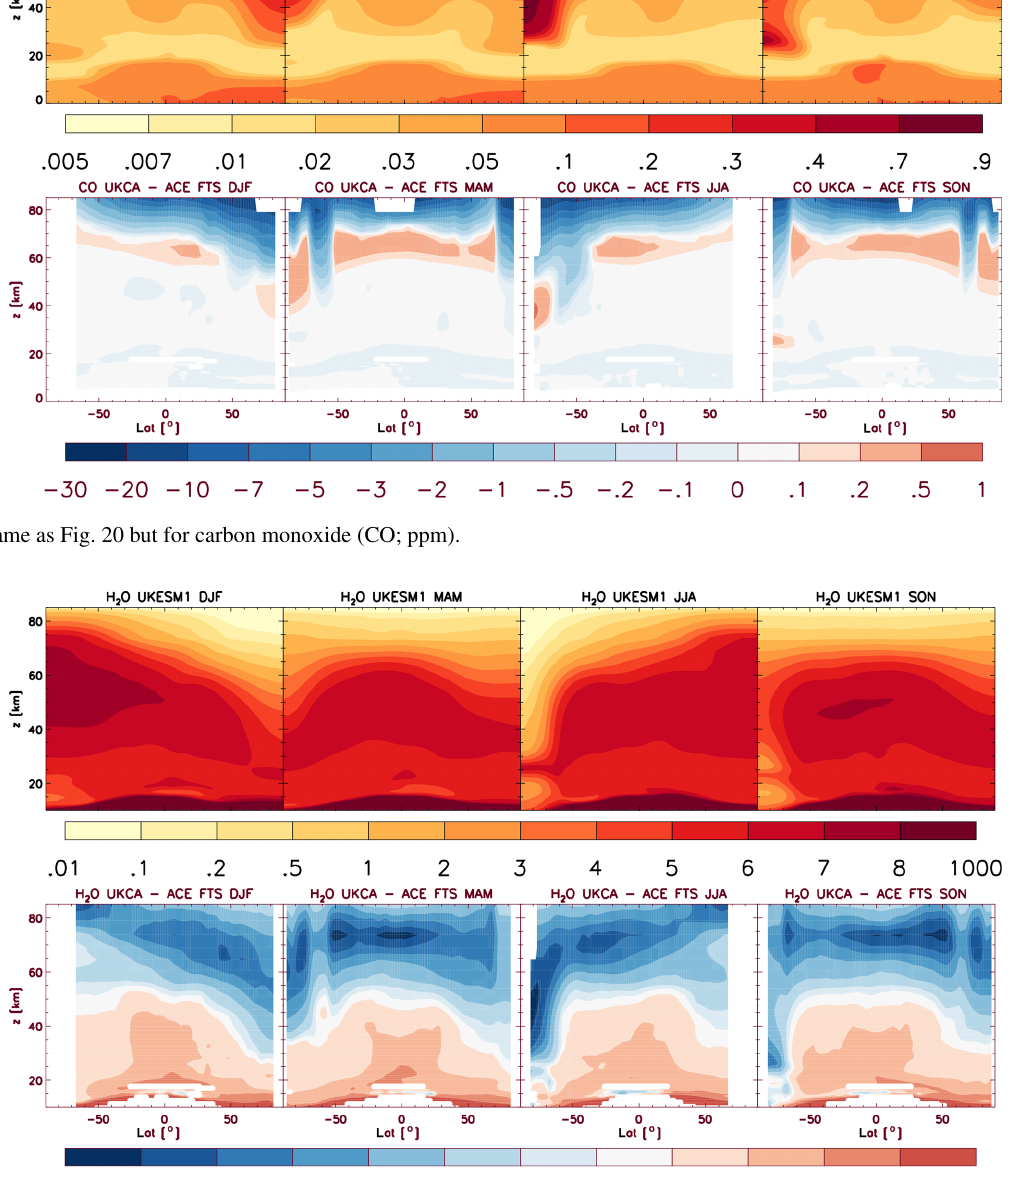
Figure 23. Same as Fig. 20 but for water vapour (H 2 O;